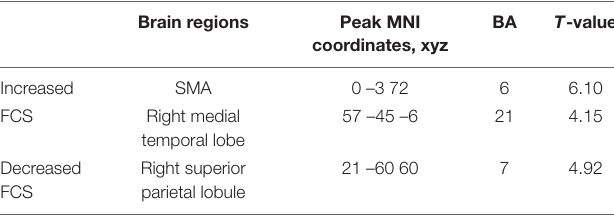
TABLE 2 | Clusters showing significant functional connectivity changes with aging.